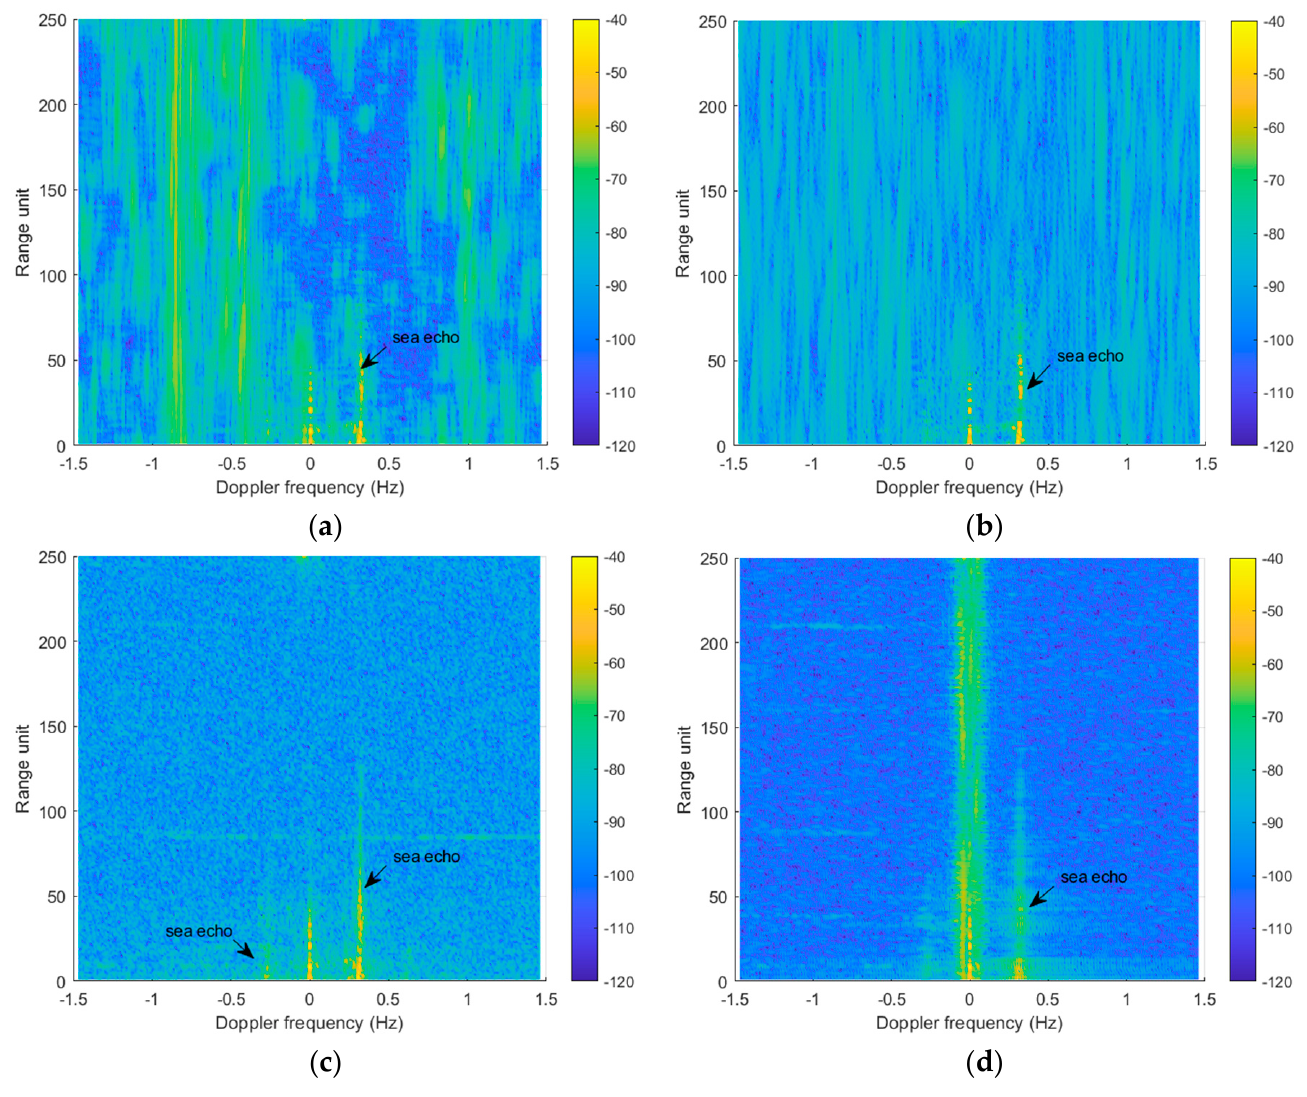
Figure 7. The range − Doppler maps of the LCI − removed results: ( a ) The RPCA method; ( b ) The BOS method; ( c ) The proposed method; ( d ) The CEMD method.